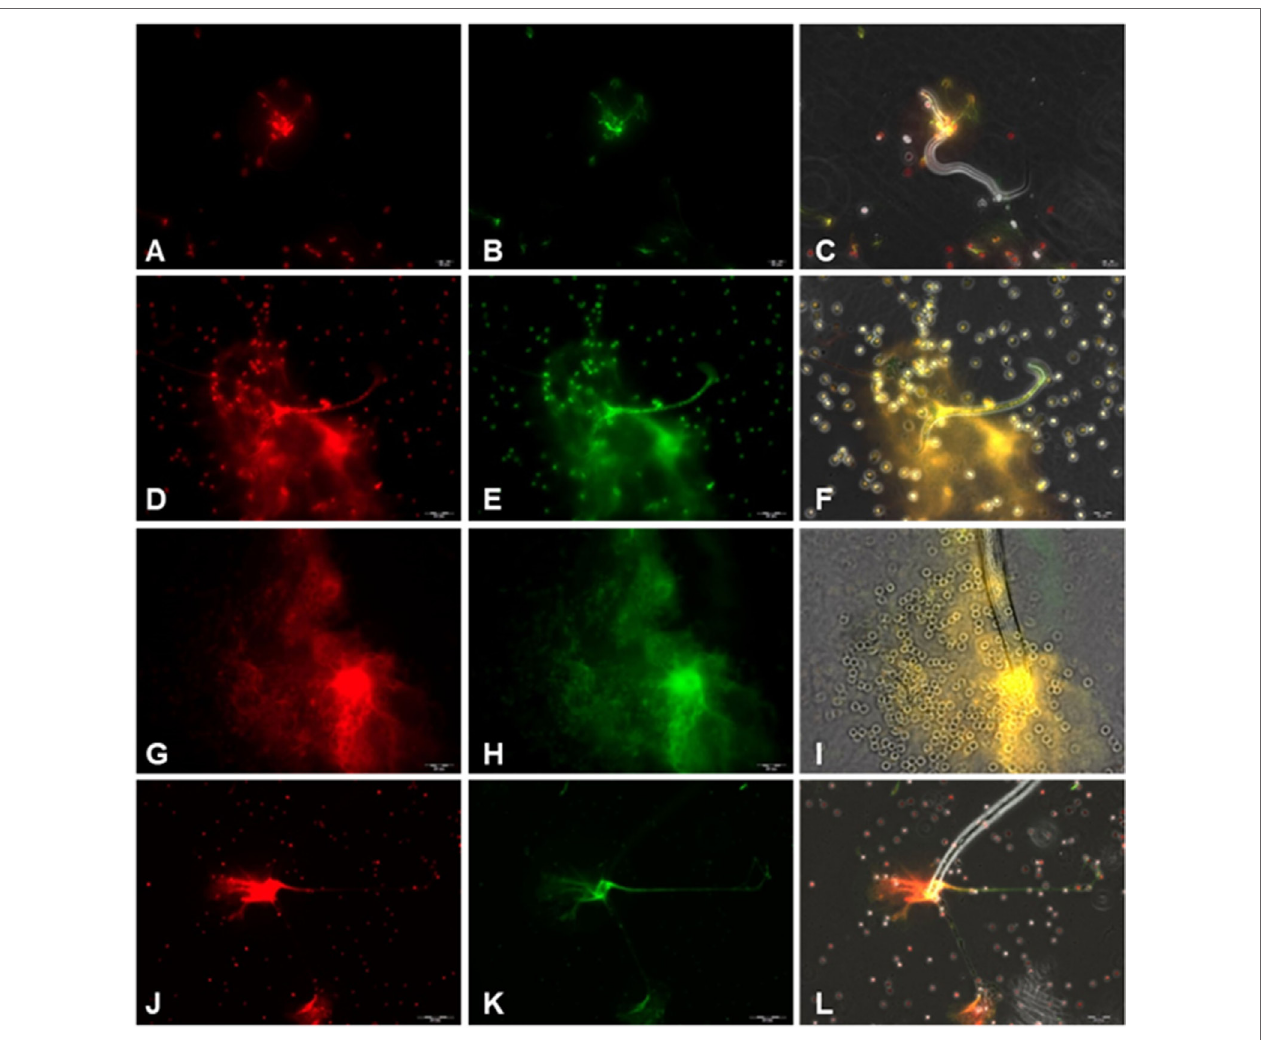
FigUre 2 | Immunofluorescence analyses on Dirofilaria immitis microfilariae-induced neutrophil extracellular trap (NET) formation. Co-localization experiments on extracellular DNA and histones, myeloperoxidase (MPO), and neutrophil elastase (NE) in D . immitis microfilariae-induced NET structures using DNA-marker Sytox Orange and anti-histone H1, H2A/H2B, H3, H4, anti-MPO, and anti-NE antibodies. (a,D,g,J) Extracellular DNA stained with Sytox Orange (red). (B) Anti-histone (green). (e,h) Anti-NE (green). (K) Anti-MPO (green). (c,F,i,l)